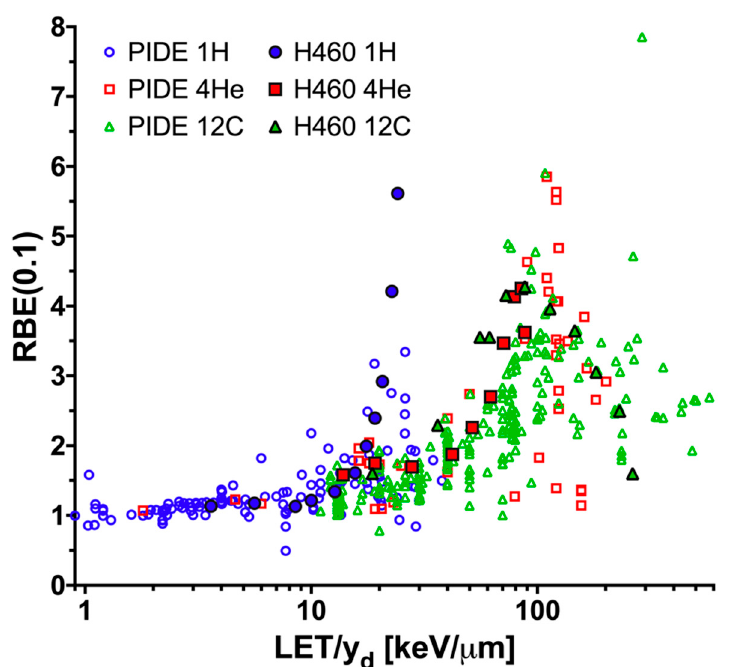
Figure 5. Relative biological effectiveness (RBE) versus LET/y d results in the context of the PIDE database and the H460 data from the current study. The RBE was calculated at a surviving fraction level of 0.1 (RBE (0.1 SF)) for cells exposed to protons (blue circles), helium ions (red squares), or carbon ions (green triangles). The H460 results from the current study (solid shapes; black outline) and the data present in the PIDE database (open shapes) are plotted for visual comparison. LET is used for the PIDE data while y d is used for the current H460 data.